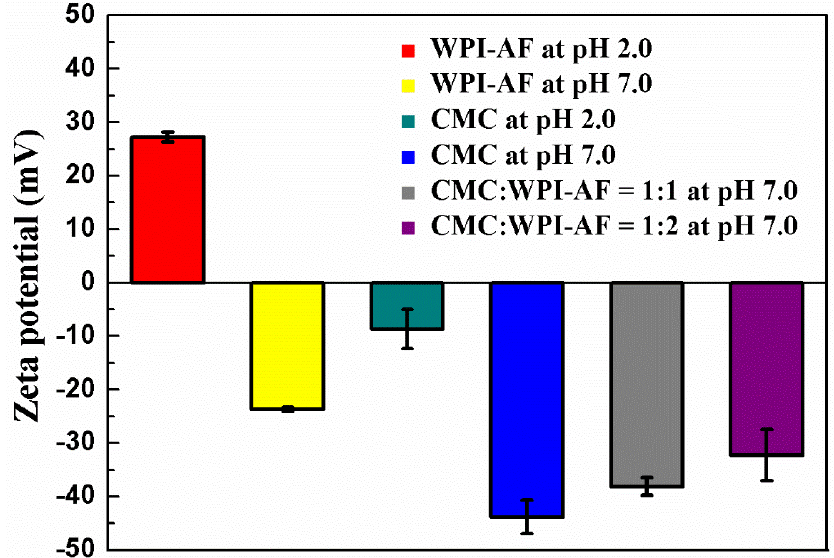
Figure 4. Zeta potentials of WPI - AF, CMC, and CMC/WPI - AF with different mass